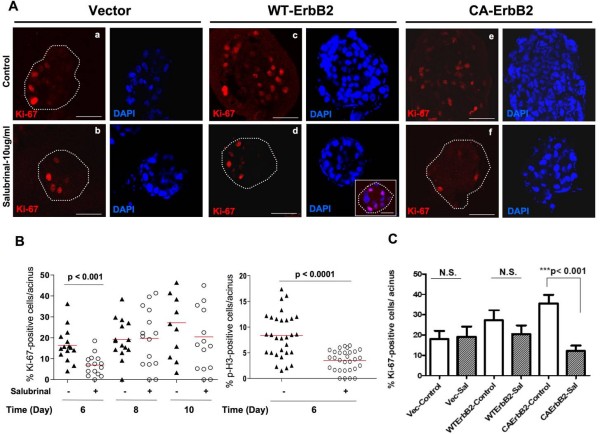
Induction of eIF2α phosphorylation by salubrinal inhibits ErbB2-induced hyperproliferation. (A) Representative confocal images of equatorial cross-sections through day 10 vector control, wild type and constitutively active ErbB2 acini stained for Ki-67 (red) or the corresponding images stained with DAPI (blue). Untreated acini (panels a, c and e) and salubrinal treated acini (panels b, d and f). Note Ki-67-positive cells in the outer basal layer of cells in untreated vector control acini (outlined in dotted lines in some structures where edges are not obvious) compared to those occupying the central luminal space in untreated ErbB2-over-expressing acini. Scale bars = 40 μm. Inset (panel d) depicts a smaller salubrinal-treated Wt-ErbB2 acinus with many Ki-67 positive cells. (B) Graph showing distribution of the percentage of wt-ErbB2 cells per acinus that stained positively for Ki-67 at days 6, 8 and 10 (left panel) or phospho-H3 at day 6 (right panel); horizontal red line indicates the median. Statistical significance was determined using the unpaired t-test with p < 0.05 defined as statistically significant. N.S - not significant. Salubrinal treatment significantly decreases the percentage of Ki-67 positive cells in WT-ErbB2 acini only early at day 6.(C) Graph showing distribution of the percentage of cells per acinus that stained positively for Ki-67 cells; mean ± SEM. Statistical significance was determined using the unpaired t-test with p < 0.05 defined as statistically significant. N.S - not significant. Note the increase in percentage of Ki-67 positive cells in untreated CA-ErbB2 expressing acini compared to vector controls. Salubrinal treatment significantly decreases the percentage of Ki-67 positive cells in CA-ErbB2 acini.